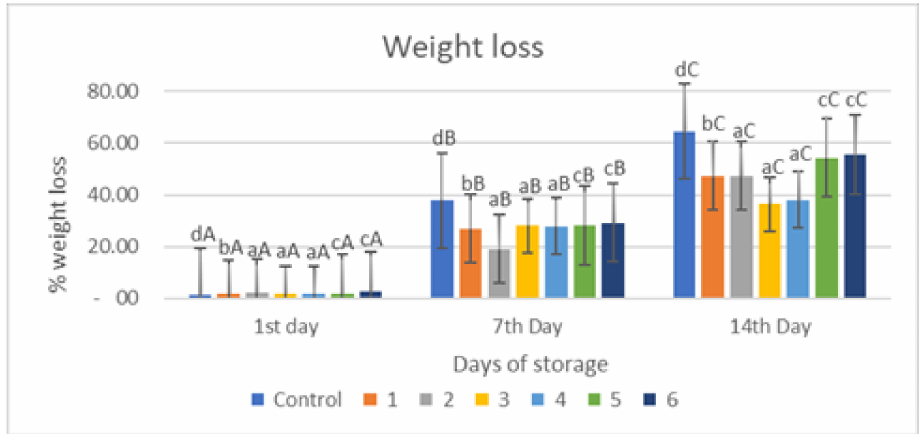
Figure 2. Effect of an edible coating of Tilapia gelatin–pectin composite with incorporated garlic essential oil on weight loss of red chili during storage The value shown is the average of the three experimental replications. Control: Uncoated Sample; 1: Gelatin75%-Pectin25%-Garlic Essential Oil2%; 2: Gelatin75%-Pectin25%-Garlic Essential Oil Oil3%; 3: Gelatin50%-Pectin50%-Garlic Essential Oil Oil2%; 4: Gelatin50%-Pectin50%-Garlic Essential Oil Oil3%; 5: Gelatin25%-Pectin75%-Garlic Essential Oil Oil2%; 6: Gelatin25%-Pectin75%-Garlic Essential Oil Oil3%. a–d non-capital letters show the difference between the samples ( p < 0.05). A–C capital letters show the difference between the day of storage ( p <